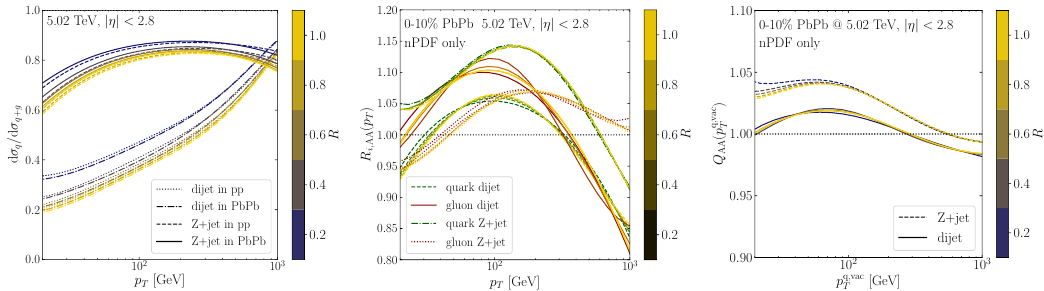
Figure 10 . Left : the parametrized quark jet contribution in pp and in PbPb using the nPDF in Pythia. Middle : the quenching factors for quarks and gluons resulting from nPDFs (no quenching). Right: the quantile ratio resulting from nPDFs